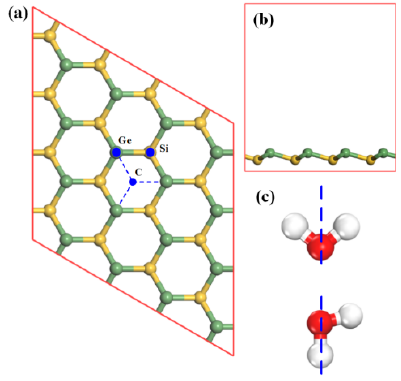
Figure 1. ( a ) Schematic view of the geometric structure for 4 × 4 SiGe monolayer with three selected adsorption sites (Ge atom site, Si atom site, and center site of hexagon); ( b ) the side view of SiGe monolayer; and ( c ) gas molecule orientations (taking the H 2 O molecule as an example).